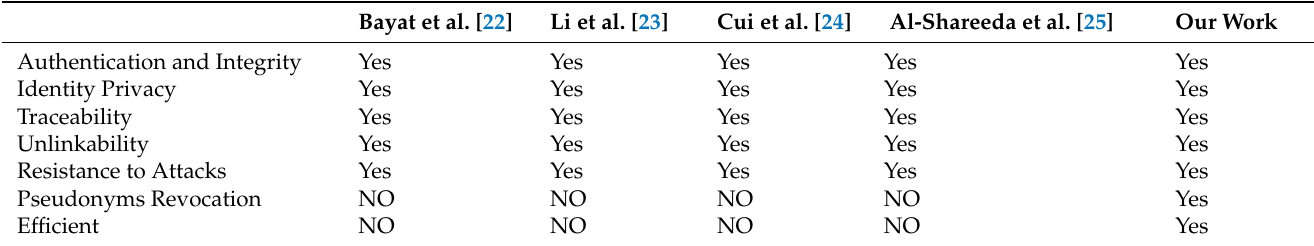
Table 1. Assessment of Present Authentication Systems’ Security. Look to Section 3.2 for explanation of the seven criteria of comparison.